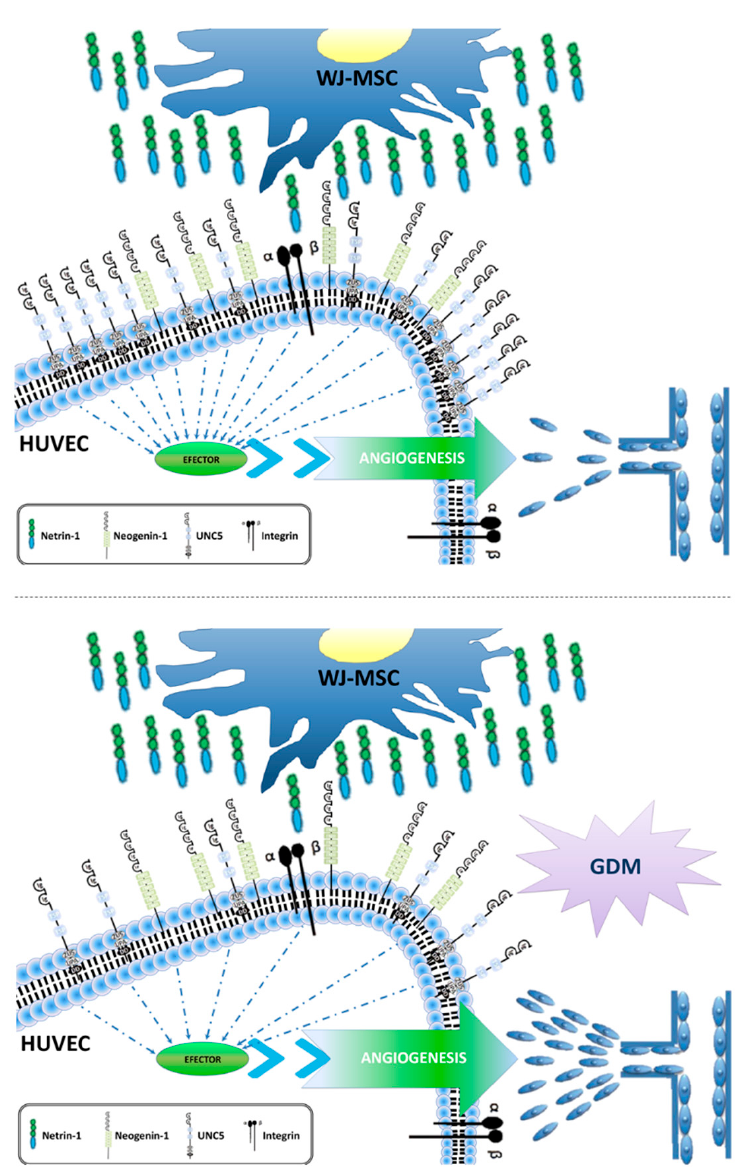
Figure 5. Working Model. Model integrating the pro-angiogenic effect of Netrin-1 secretion by WJ-MSC. Endothelial cells express both classical UNC5b and UNC5c, as well as non-classical receptors (Integrins) for Netrin-1. Considering that UNC5b is an anti-angiogenic receptor, it is feasible that loss of UNC5b in endothelial cells promotes alterations in placental angiogenesis, as observed in GDM.